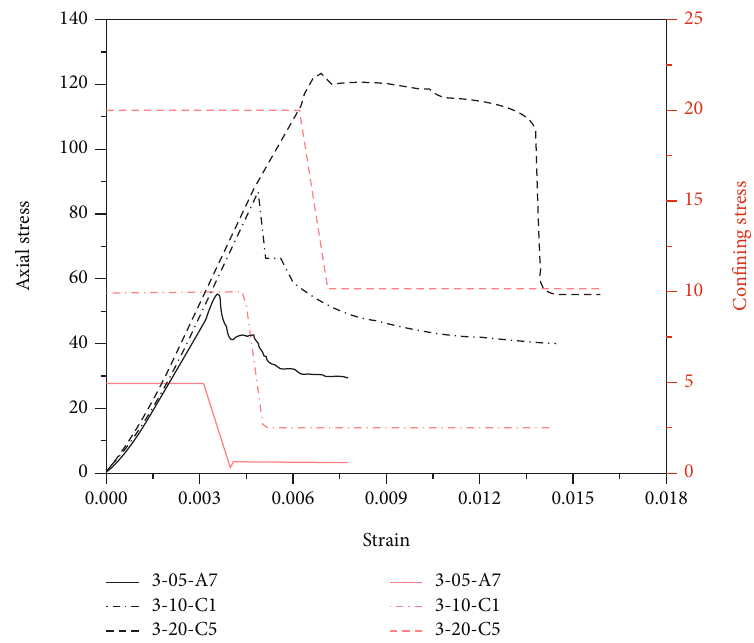
Figure 10: Axial stress/con fi ning pressure-strain relations of Scheme 3 under di ff erent con fi ning